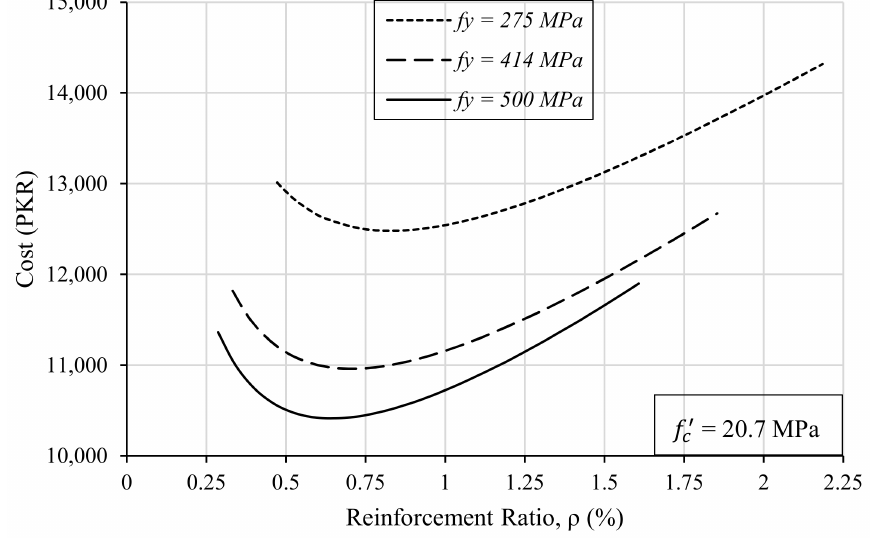
Figure 10. The effect of steel strength on the steel ratio and the cost of the